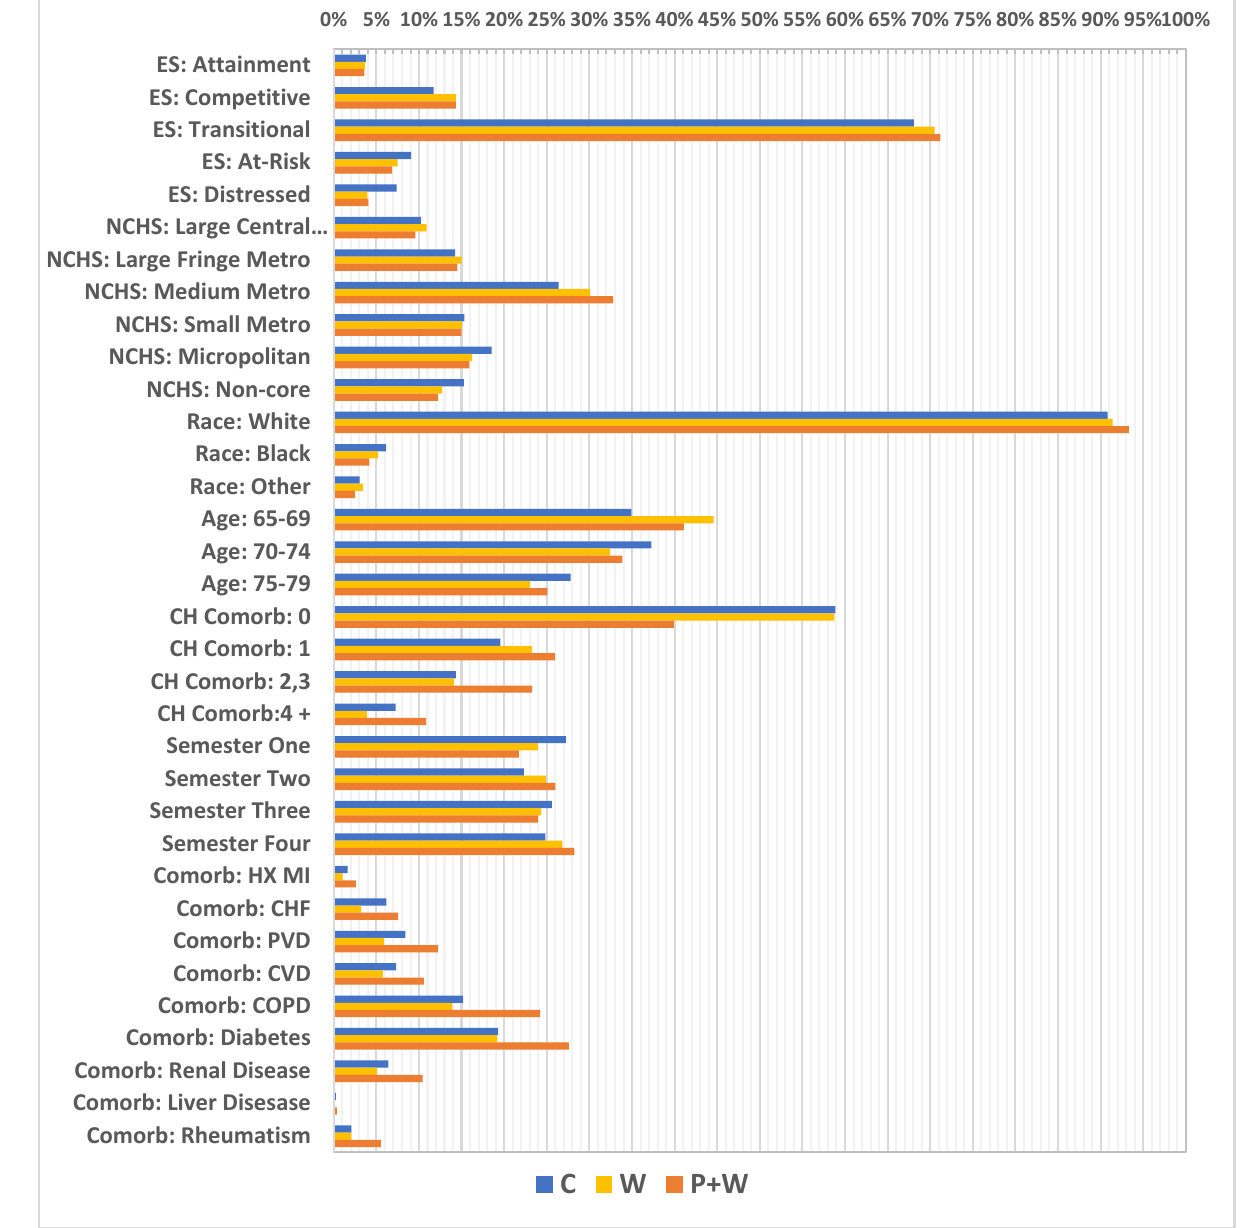
Figure 3. Unweighted covariate distributions . ES—economic status; NCHS—National Center for Health Statistics; Metro—metropolitan; CH Comorb—Charlson comorbidity index; HX MI—history of myocardial infraction; CHF—chronic heart failure; PVD—peripheral vascular disease; CVD— cardiovascular disease; COPD—chronic obstructive pulmonary disease.